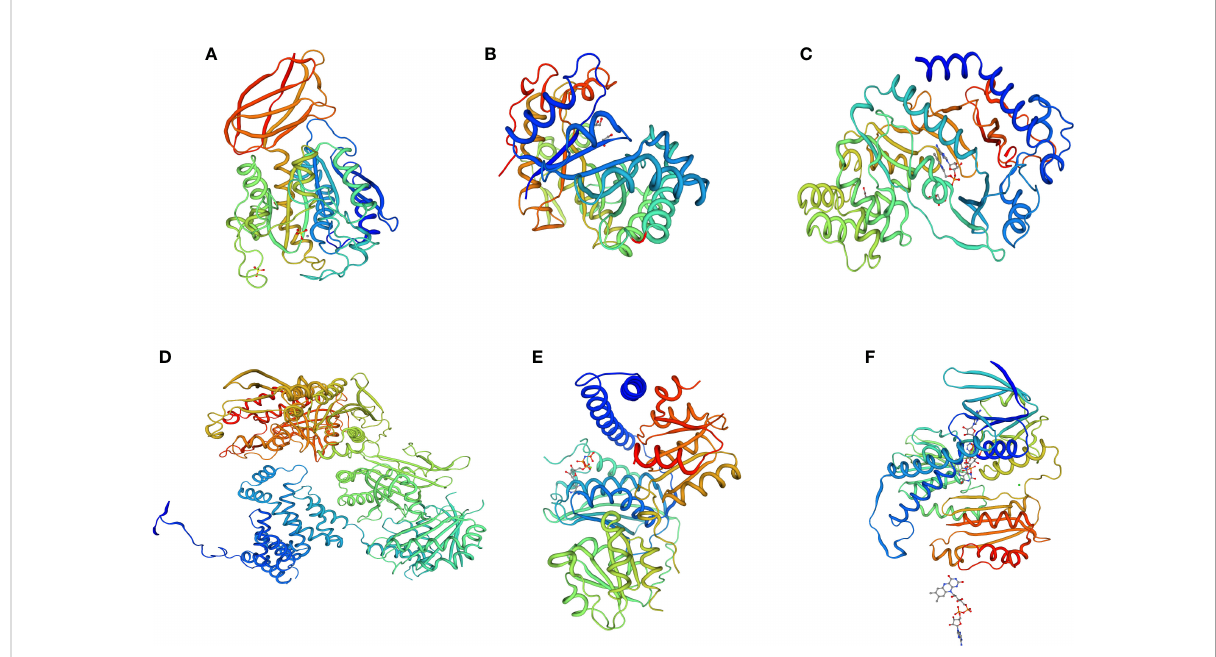
FIGURE 11 3D protein structure prediction of three downregulated unigenes (A) DN399333_c0_g2_i4 (GH3-1 auxin conjugating enzyme), (B) DN37014_c0_g1_i1 (pollen allergen CJP38), and (C) DN42426_c0_g1_i16 (carboxypeptidase GP 180 residues 503-882), as well as three upregulated unigenes (D) DN43311_c0_g5_i10 (acetyl-CoA carboxylase), (E) DN45321_c1_g3_i8 (hybrid kinase), and (F) DN42426_c0_g1_i16 (dihydrolipoyl dehydrogenase) obtained from the six fi nger millet genotypes (AT1, AT2, AT3, AS1, AS2, and